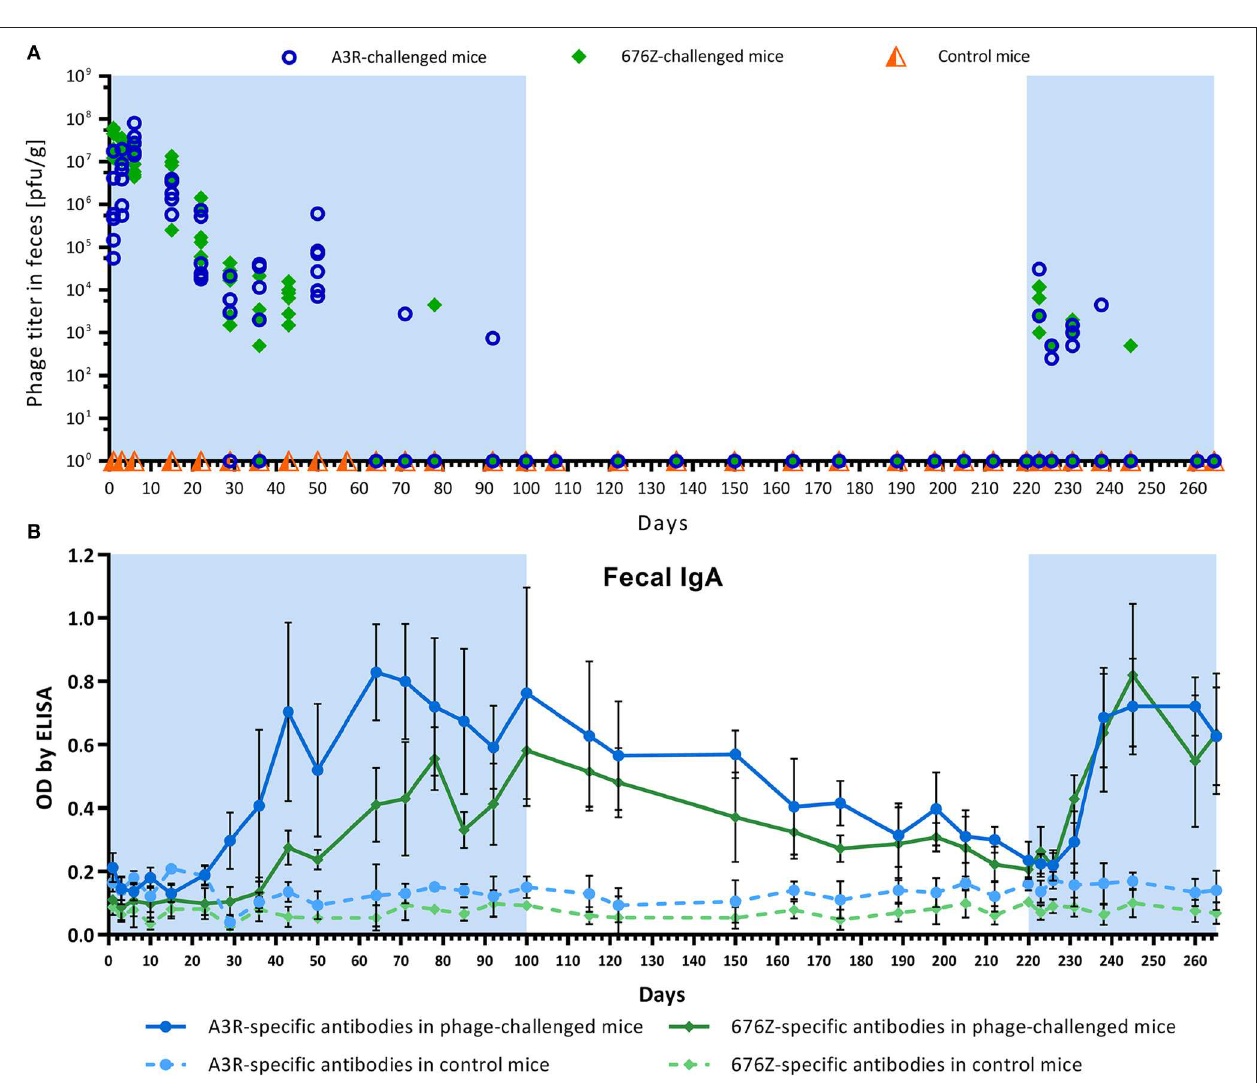
FIGURE 1 | Phage transit through the GI tract (A) and changes of specific anti-phage IgA levels in murine fecal samples (B) in mice treated with phages A3R or 676Z. Antibody levels were evaluated using enzyme-linked immunosorbent assay (ELISA). Mice ( N = 6) were administered purified preparations of phages A3R or 676Z in drinking solution of the final concentration 4 × 10 9 pfu/ml. Phage-enriched drinking water was administered as the only water source continuously for 100 days. For the following 120 days phage preparations were removed from the diet and then introduced again for the final 44 days of the experiment. The periods of phage treatment are indicated in the figure as a light blue background. Control mice were separated from phage-treated mice and received no phage in the diet. They were examined for presence of phages active against A3R and 676Z bacterial S. aureus host strains and no phage activity was detected during the whole experiment. The experiment was repeated twice with concordant results. One representative experiment is presented in the figure.